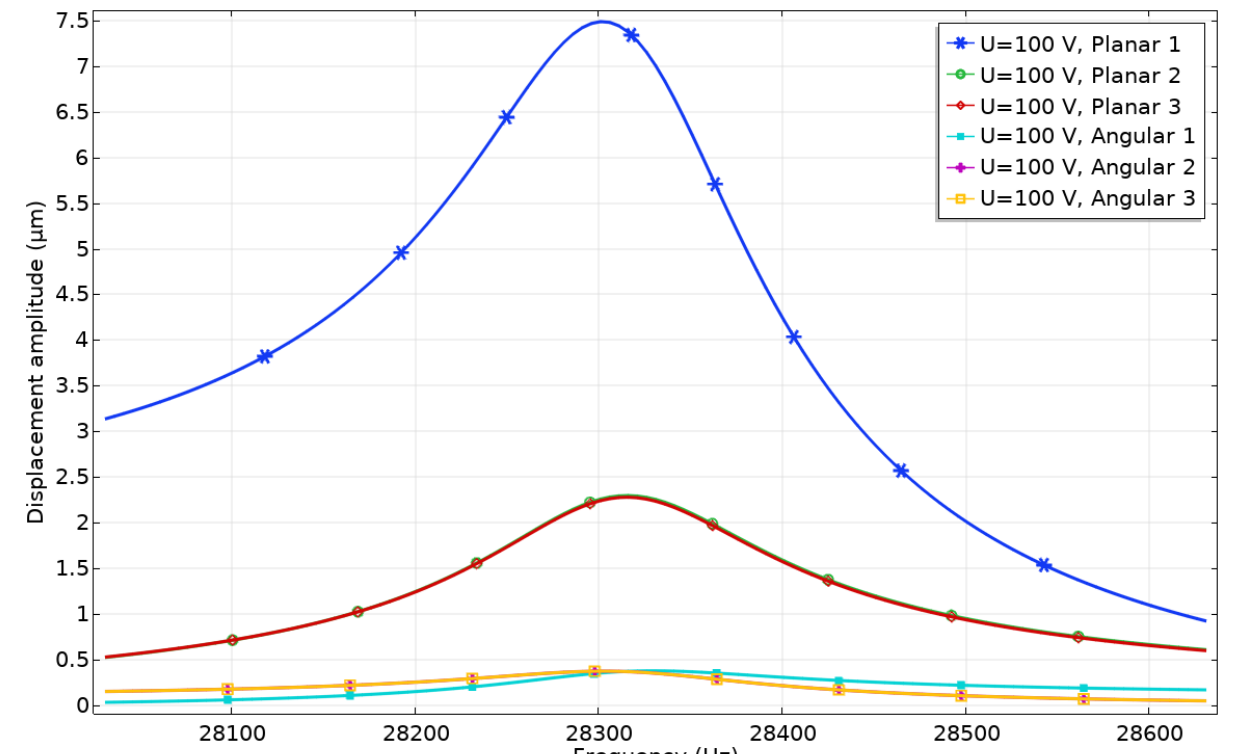
Figure 6. Amplitude—frequency characteristics of the contacting points when electrode Planar 1 is affected by the voltage of 100 V p-p.